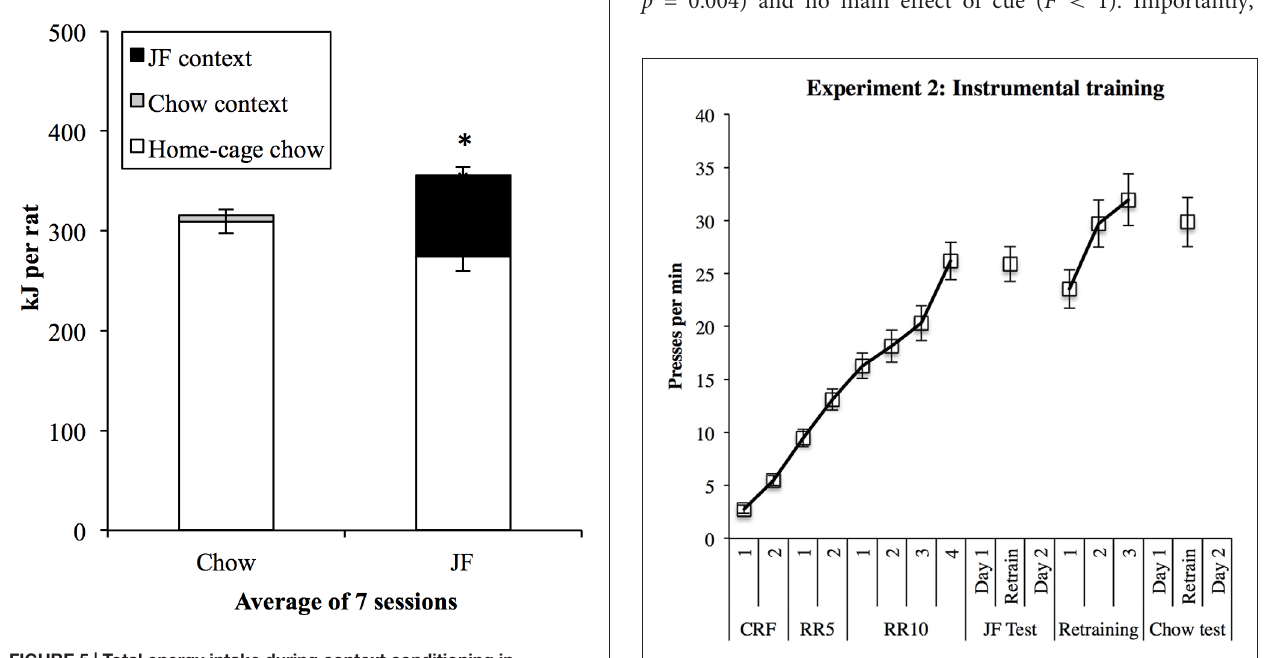
FIGURE 6 | Instrumental training in Experiment 2. Responding increased steadily throughout training and remained high during re-training sessions between outcome devaluation